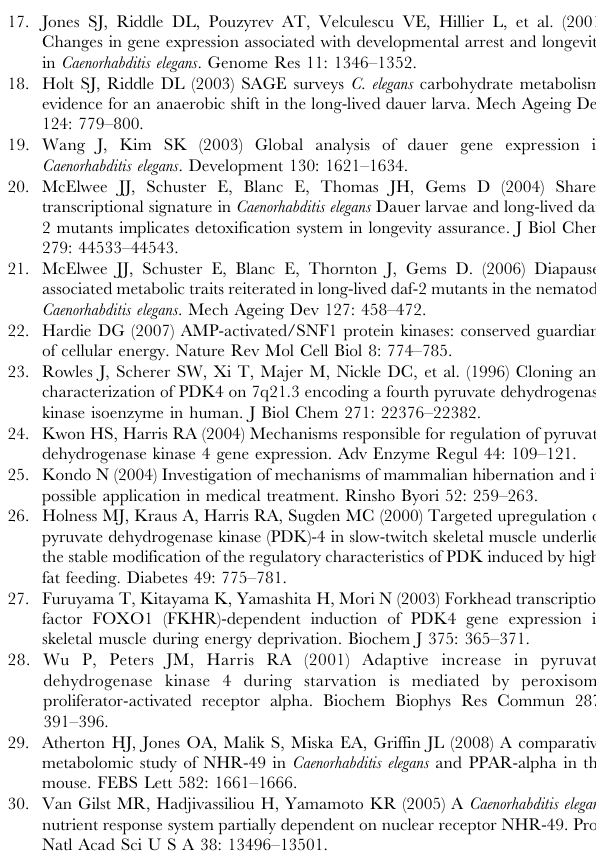
Figure S3 Expression pattern of the PDHK-2::GFP in C. elegans . A PDHK-2/GFP fusion construct was microinjected into N2 worms. ( A ) and ( B ), GFP-tagged PDHK-2 promoter is shown to be expressed in the head, intestine and the nuclei of intestinal cells. ( C ) and ( D ), pdhk-2 p::PDHK-2::GFP expressed in the head and intestine. Both constructs were microinjected into worms at 50–100 ng/ m l. Scale bar: 50 m m (TIF) Figure S4 Expression of PDHK-2 in the head neurons of JK2868 dauer stage worms. pdhk-2 p::PDHK-2::red fluores- cent protein constructs were microinjected into JK2868 worms at 50–100 ng/ m l. Dauer worms following 7 days of starvation at 25 u C. Red indicates pdhk-2 p::PDHK-2::red fluorescent protein and green corresponds to lag-2 p::GFP. Scale bar: 50 m m.